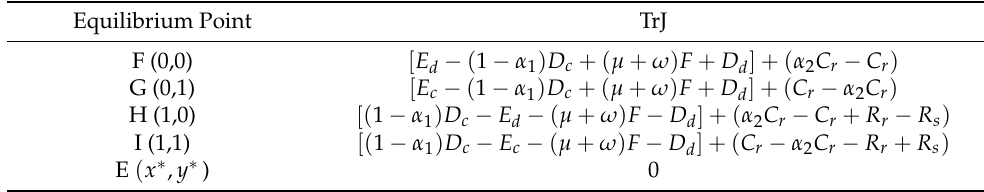
Table 7. Traces of system equilibrium